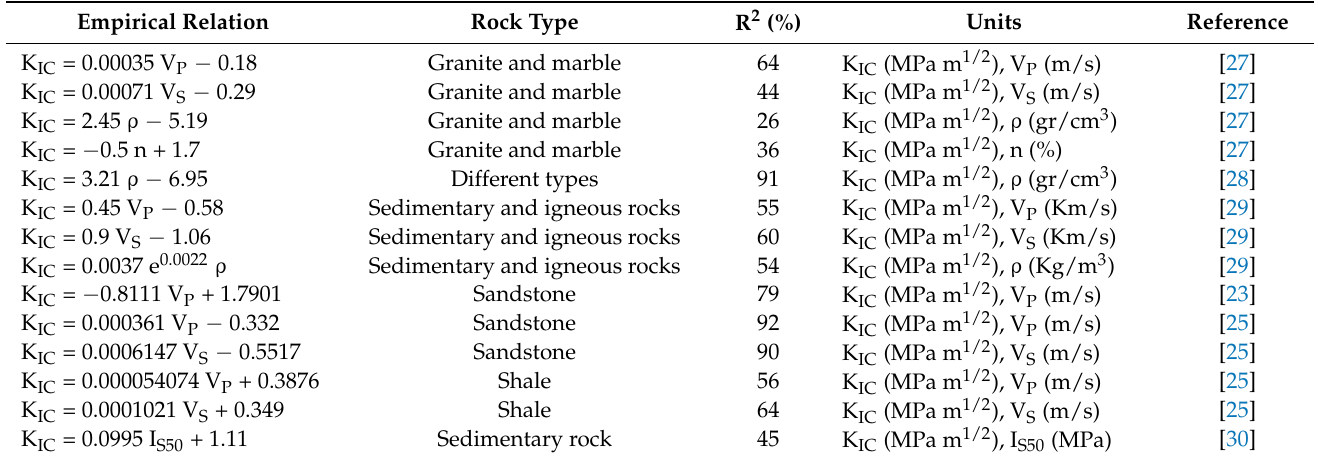
Table 1. Some empirical relationships between K IC and index